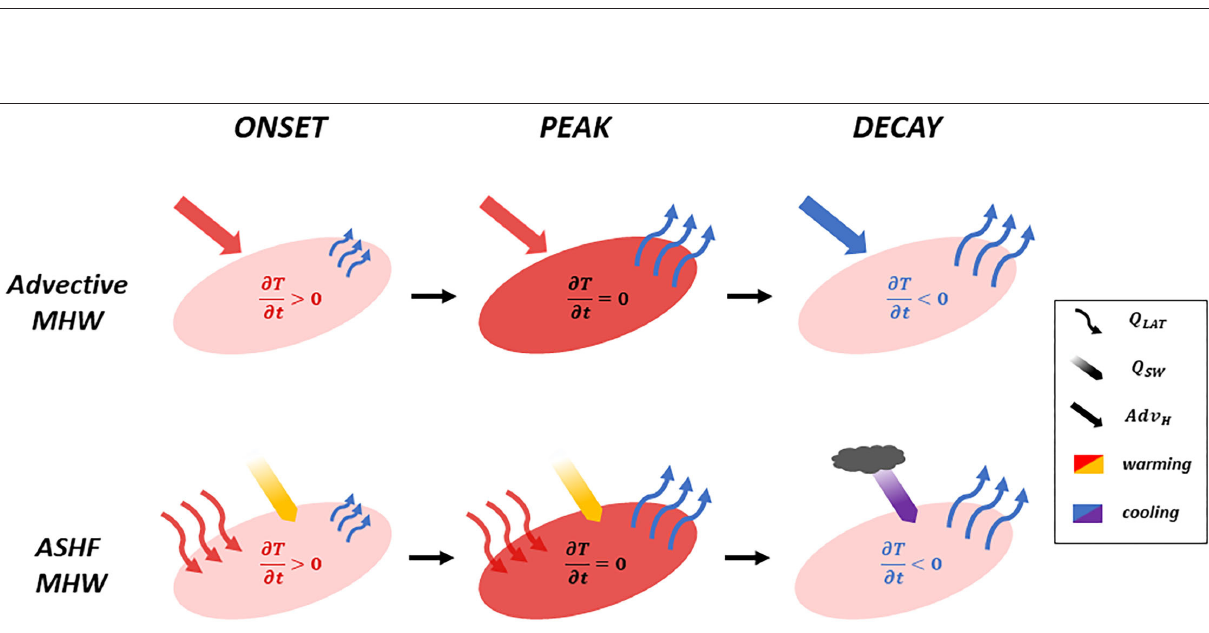
Frontiers in Climate |